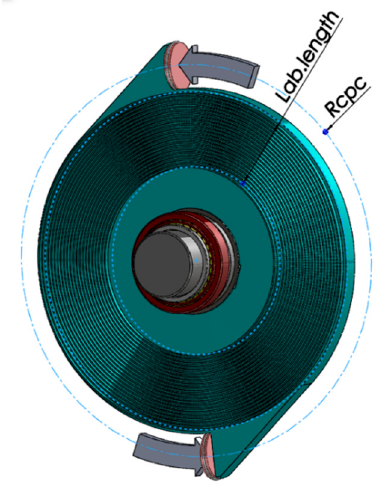
Figure 3. The pressure force applied on the piston is always vertical.